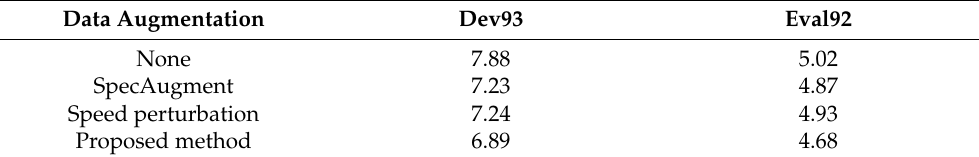
Table 6. WER (%) results of WSJ database according to data augmentation methods.